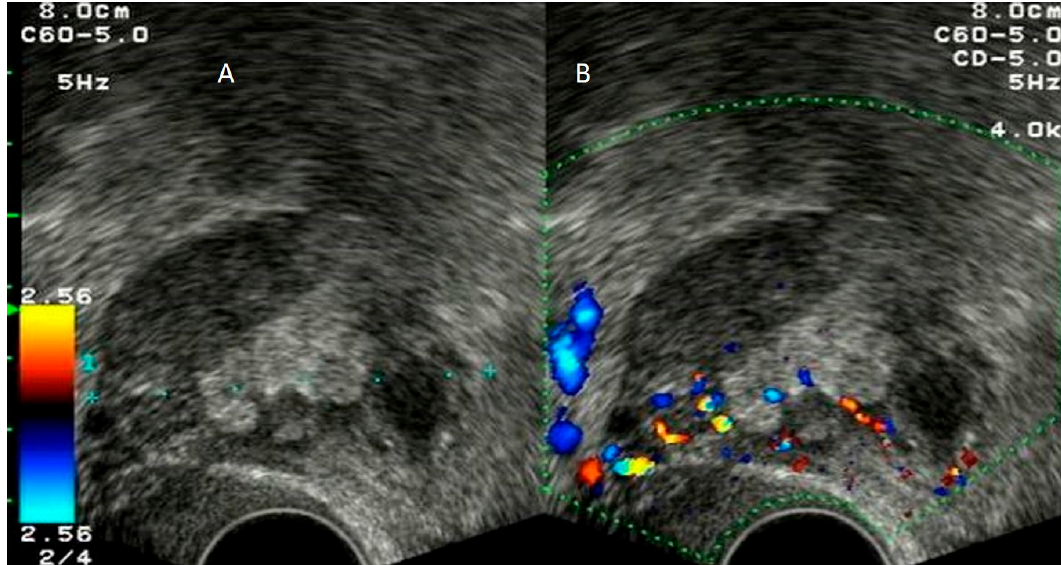
Figure 4. Grayscale ( A ) and color Doppler ( B ) of appendicular plastron showing a vascularized het- erogeneous mass in the right iliac fossa.